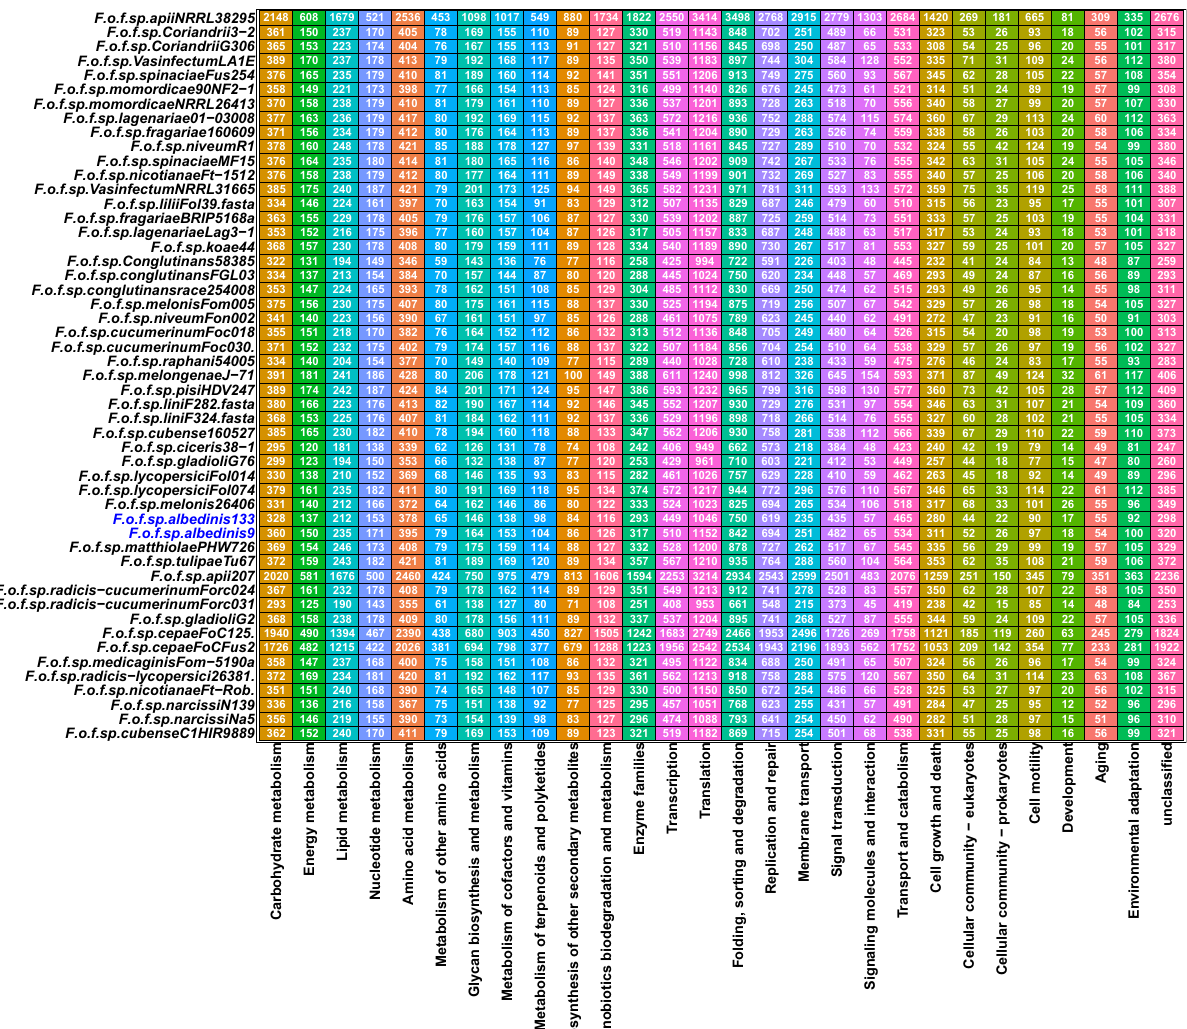
F.o.f.sp.matthiolaePHW726F.o.f.sp.albedinis9F.o.f.sp.albedinis133F.o.f.sp.melonis26406F.o.f.sp.lycopersiciFol074F.o.f.sp.lycopersiciFol014F.o.f.sp.gladioliG76F.o.f.sp.ciceris38−1F.o.f.sp.cubense160527F.o.f.sp.liniF324.fastaF.o.f.sp.liniF282.fastaF.o.f.sp.pisiHDV247F.o.f.sp.melongenaeJ−71F.o.f.sp.raphani54005F.o.f.sp.cucumerinumFoc030.F.o.f.sp.cucumerinumFoc018F.o.f.sp.niveumFon002F.o.f.sp.melonisFom005F.o.f.sp.conglutinansrace254008F.o.f.sp.conglutinansFGL03F.o.f.sp.Conglutinans58385F.o.f.sp.koae44F.o.f.sp.lagenariaeLag3−1F.o.f.sp.fragariaeBRIP5168aF.o.f.sp.liliiFol39.fastaF.o.f.sp.VasinfectumNRRL31665F.o.f.sp.nicotianaeFt−1512F.o.f.sp.spinaciaeMF15F.o.f.sp.niveumR1F.o.f.sp.fragariae160609F.o.f.sp.lagenariae01−03008F.o.f.sp.momordicaeNRRL26413F.o.f.sp.momordicae90NF2−1F.o.f.sp.spinaciaeFus254F.o.f.sp.VasinfectumLA1EF.o.f.sp.CoriandriiG306F.o.f.sp.Coriandrii3−2F.o.f.sp.apiiNRRL38295 F.o.f.sp.tulipaeTu67 F.o.f.sp.cubenseC1HIR9889F.o.f.sp.narcissiNa5F.o.f.sp.narcissiN139F.o.f.sp.nicotianaeFt−Rob.F.o.f.sp.radicis−lycopersici26381.F.o.f.sp.medicaginisFom−5190aF.o.f.sp.cepaeFoCFus2F.o.f.sp.cepaeFoC125.F.o.f.sp.gladioliG2F.o.f.sp.radicis−cucumerinumForc031F.o.f.sp.radicis−cucumerinumForc024F.o.f.sp.apii207 Figure 4. Predicted KEGG categories in Foa and other FOSC’s formea speciales . KEGG annotations are provided using the profile database that is integrated into the Kofamscan software. The numbers represent the genes number involved in each pathway for each strain. Abbreviations: F ( Fusarium ); o ( oxysporum ); f ( forma e); sp (speciales ). The names following the abbreviations represent the names of the formae speciales ; the abbreviations coming after the names of the formae speciales correspond to the strains belonging to these formae speciales (F.o.f.sp. albedinis 133: Fusarium osysporum forma specialis albedinis Foa